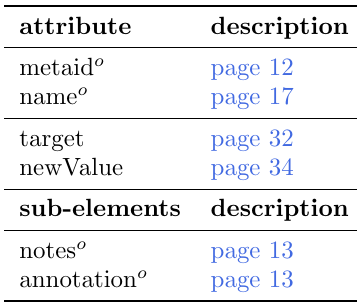
Table 2.11: Attributes and nested elements for ChangeAttribute. o denotes optional elements and